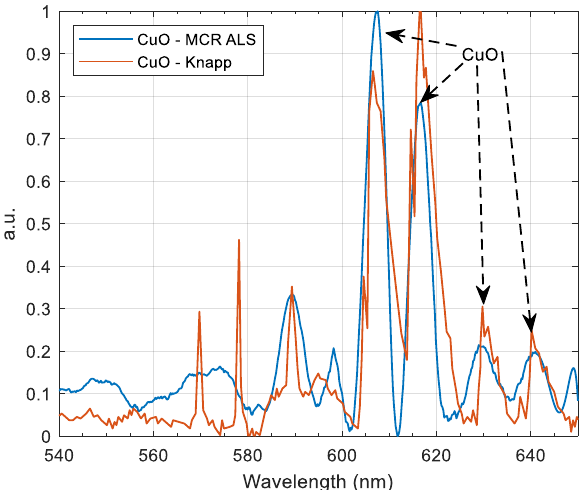
Figure 10. Spectral emission measurements obtained via MCR-ALS and reference spectral charac- teristics.